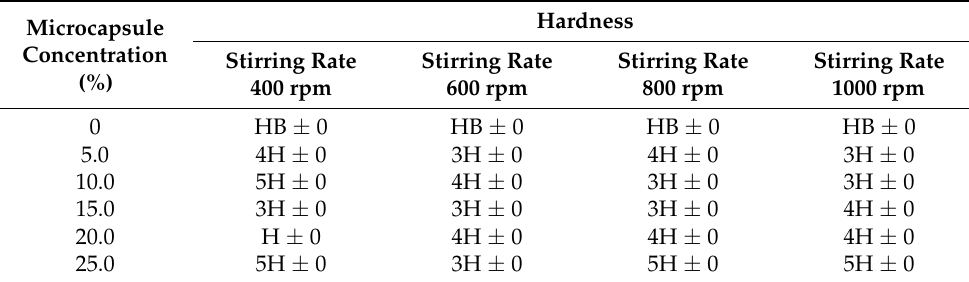
Table 4. Effect of concentration of microcapsules with different stirring rates on film hardness of waterborne